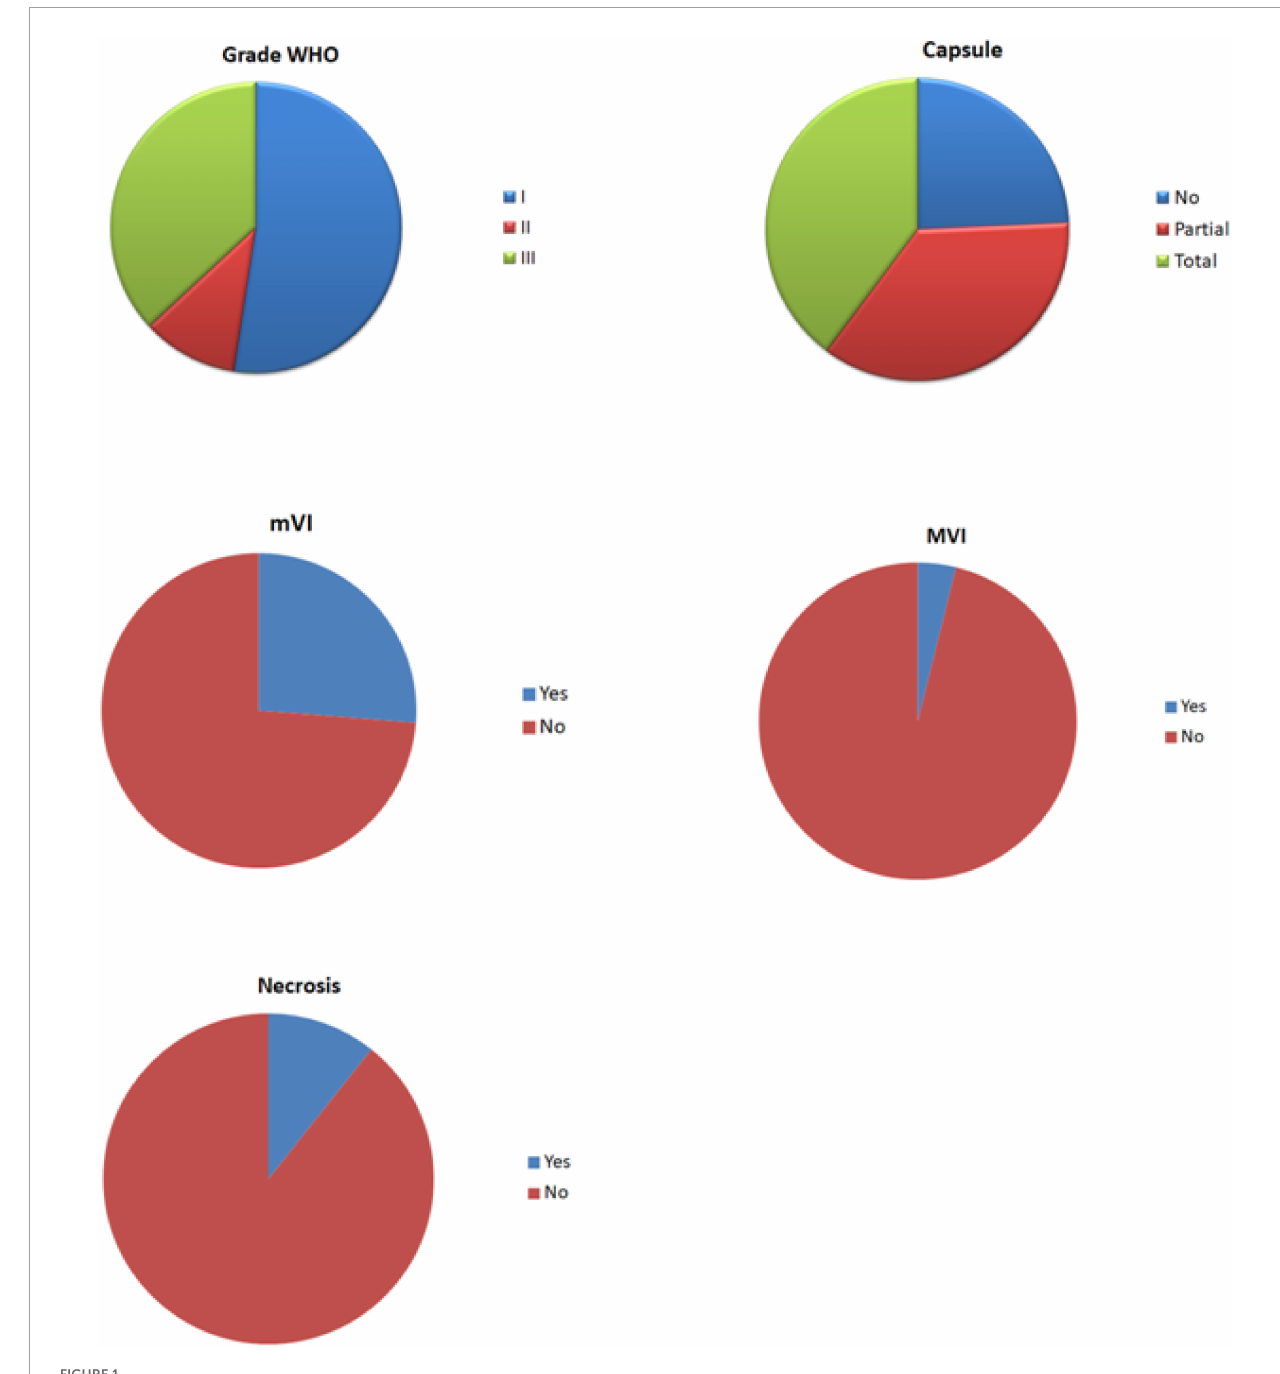
FIGURE1 Pie chart of the histological characteristics of hepatocellular carcinomas